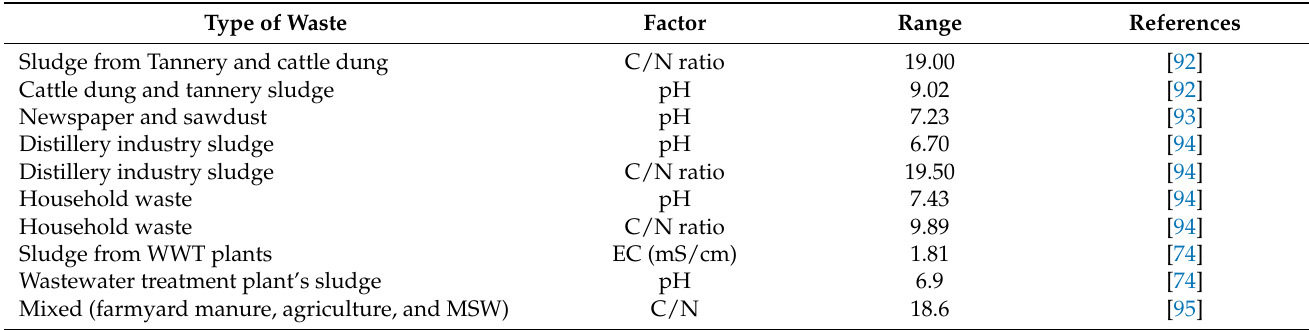
Table 3. Discrete composting parameters utilized in the vermicomposting process.